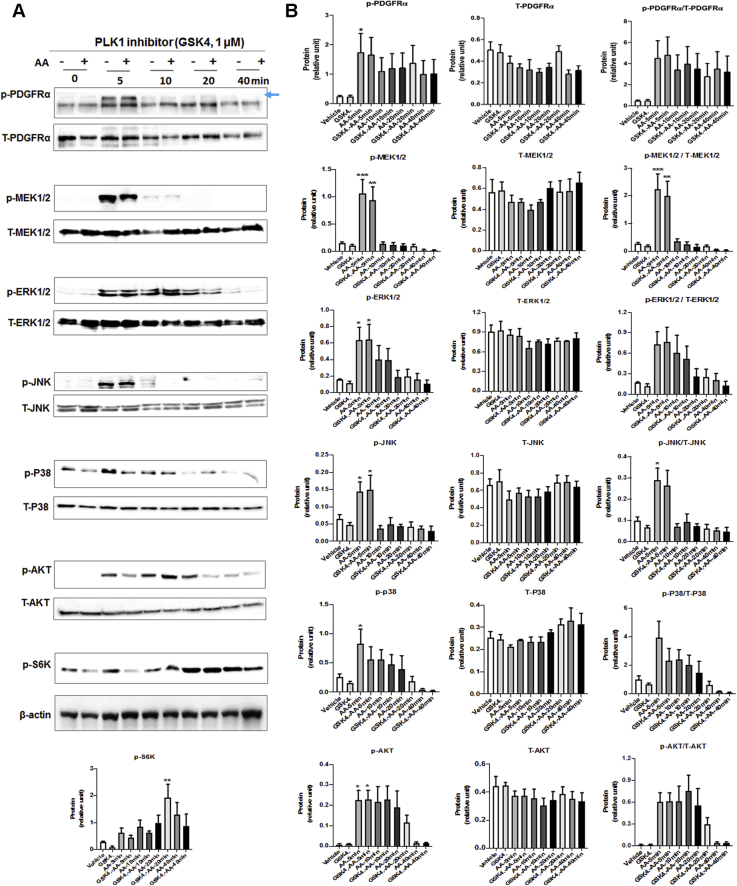
Effect of PLK1 Inhibition on Phosphorylation of PDGFR Downstream KinasesRat primary adventitial fibroblasts were cultured, starved, and pretreated with vehicle (DMSO) or PLK1-selective inhibitor GSK461364 (GSK4; 1 μmol/l, 30 min) and then stimulated with solvent or AA (60 ng/ml) before harvest for Western blotting. The arrow points to the bands of phospho-PDGFRα that were sensitive to AA stimulation. (A) Representative Western blots showing the time course of AA-induced phosphorylation of kinases. p- = phospho-protein; T- = total protein. (B) Quantification: mean ± SEM, n ≥3 experiments, 1-way ANOVA/Bonferroni test: ∗p < 0.05; ∗∗p < 0.01; ∗∗∗p < 0.001 compared with the basal control (vehicle, no AA stimulation, the first bar in each plot). Abbreviations as in Figures 1 and 4.